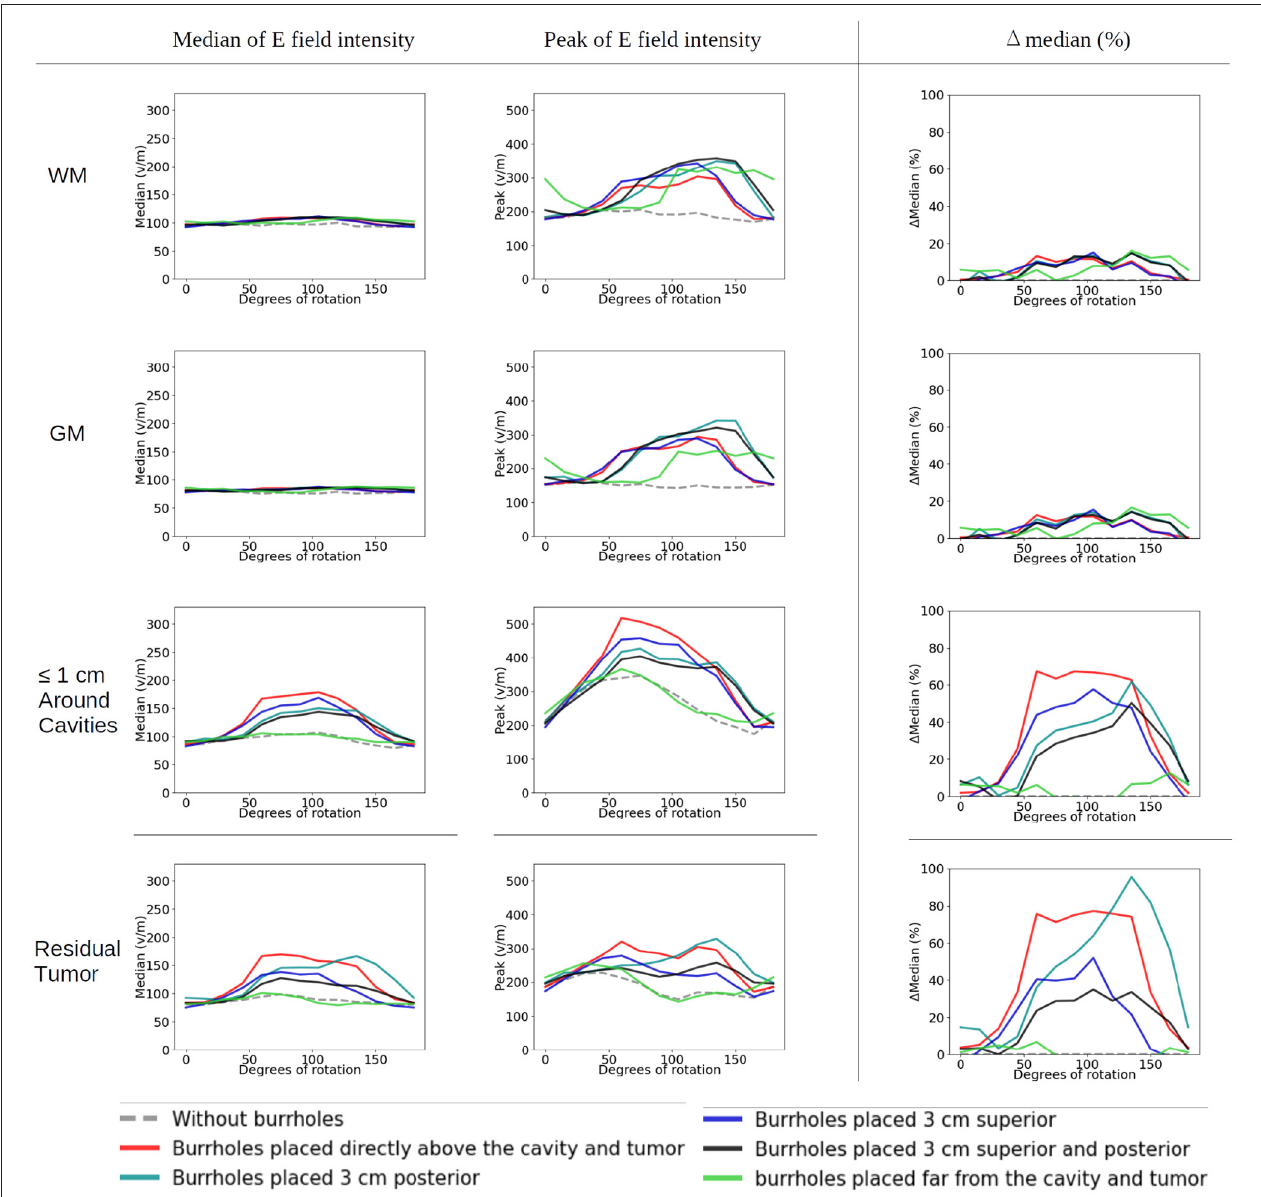
FIGURE 7 | Statistical analysis of TTFields intensities with burr holes over the resection cavity and residual tumor (solid red lines), the four alternative positions (other solid lines), and the control with no burr holes (stippled gray line). The x -axis shows the rotation degrees around the central craniocaudal z -axis ( Figures 4A , 8 ). The y -axis shows the field strength. The first two columns show median and peak field intensities for WM, GM, peri tumor and residual tumor, with all combinations of burr-hole configurations and rotational array layouts. The last column shows the enhancement of the field intensities when the SR-surgery is performed compared with the default configuration without burr